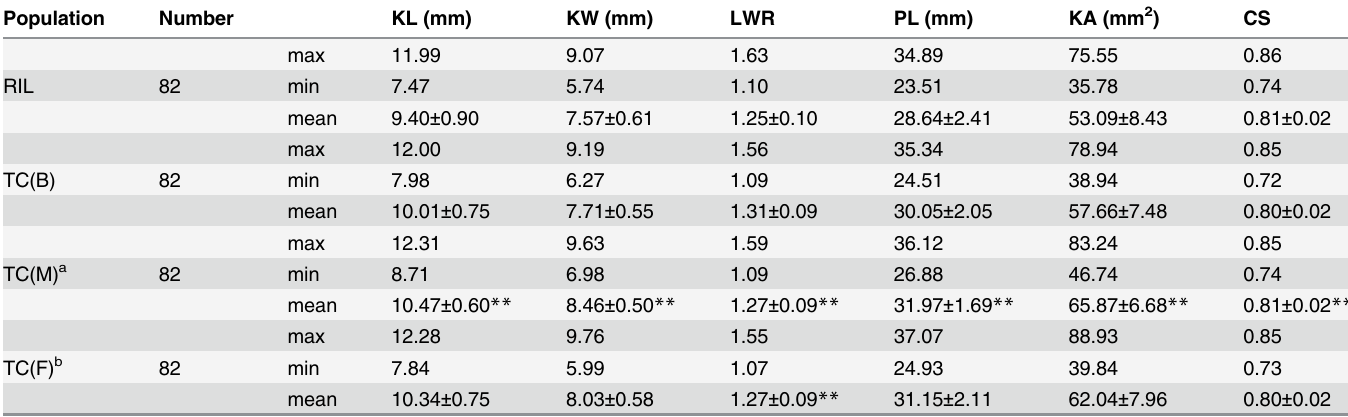
Table 2. Maximum, minimum, and mean values of RIL and TC populations based on three blocks.